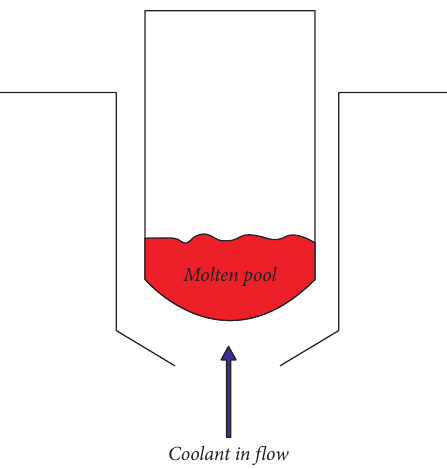
Figure 1: Schematic diagram of